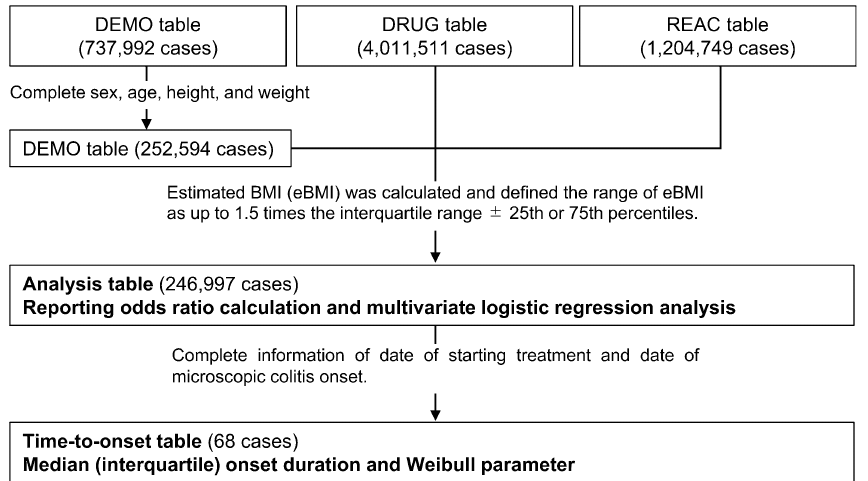
Figure 1. Flowchart of dataset construction from the Japanese Adverse Drug Event Report